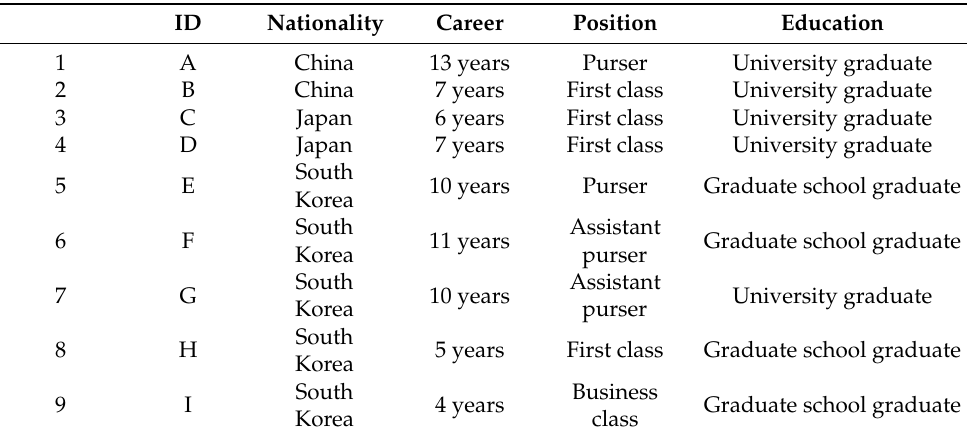
Table 2. Characteristics of in-depth interviews with participants.